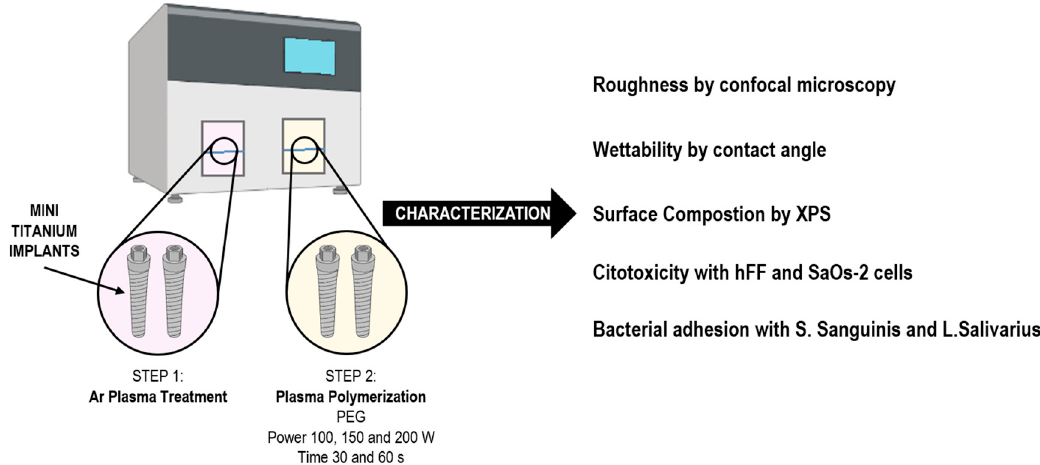
Figure 4. Schematic representation of the methodology used.